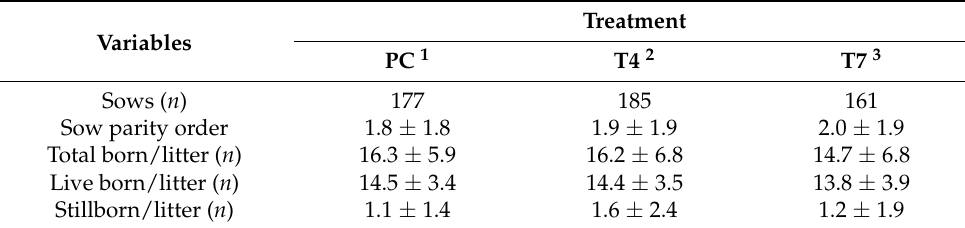
Table 1. Descriptive statistics for the number of sows and farrowing performance across treatment groups. All variables were collected prior to litter equalization on Day 1 and prior to treatment application on Day 4 or Day 7. Real means ± SD.